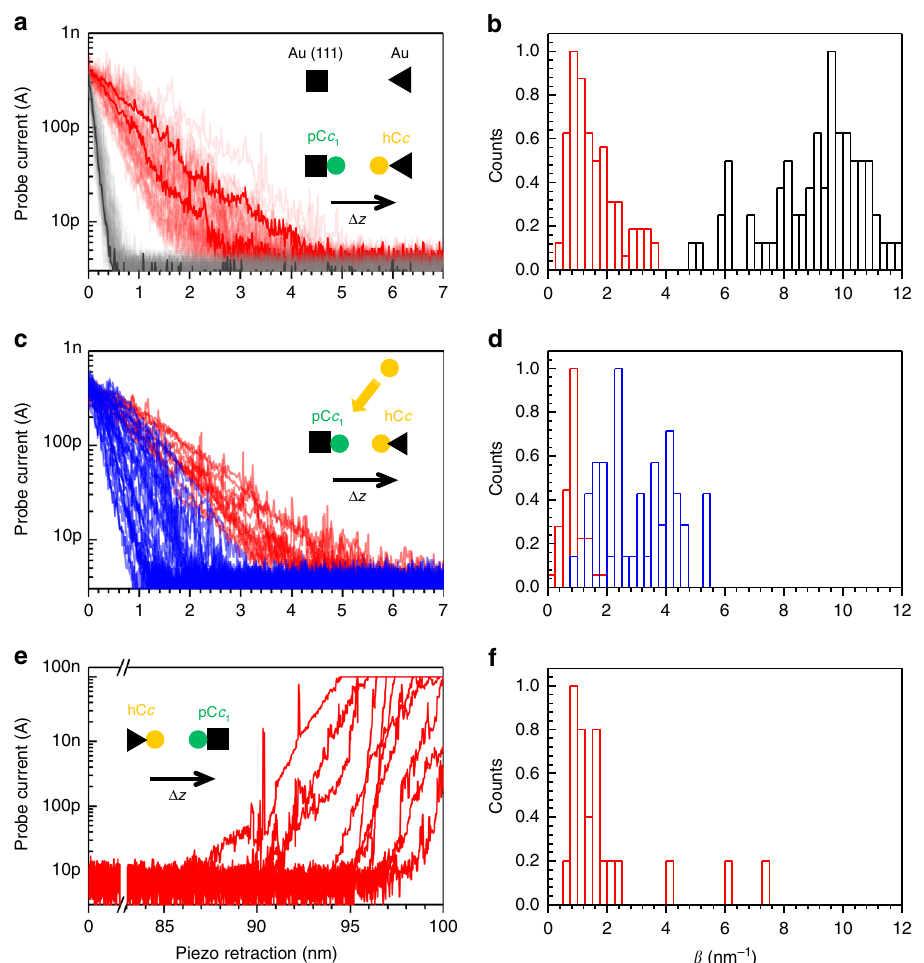
Fig. 1 Current – distance electrochemical tunneling spectroscopy of pC c 1 – hC c . a Ensemble of semilogarithmic current – distance (I-z) plots obtained for pC c 1 – hC c proteins (red) and for bare gold (gray) during probe retraction, showing a more gradual current decay for pC c 1 – hC c . Selected representative traces are depicted in bold. Sample and probe electrodes are represented by a square and a triangle, respectively. b Histograms of distance decay factors ( β ) quanti fi ed from individual curves in a . c Inhibition experiment conducted to test the speci fi city of pC c 1 – hC c . Semilogarithmic I-z plots obtained for pC c 1 – hC c during probe retraction before (red), and after (blue) the addition of WT hC c . The measured probe current is reduced more abruptly upon WT hC c addition. d Histograms of β from individual curves in c . e Selected semilogarithmic I-z plots obtained for pC c 1 – hC c obtained in approach experiments after retracting the probe 100 nm. f Histogram of β obtained from individual curves in e . All the experiments were performed at U s = − 200 mV and at constant bias of 800 mV in 50 mM sodium phosphate buffer, pH = 6.5. Initial current set point 0.4